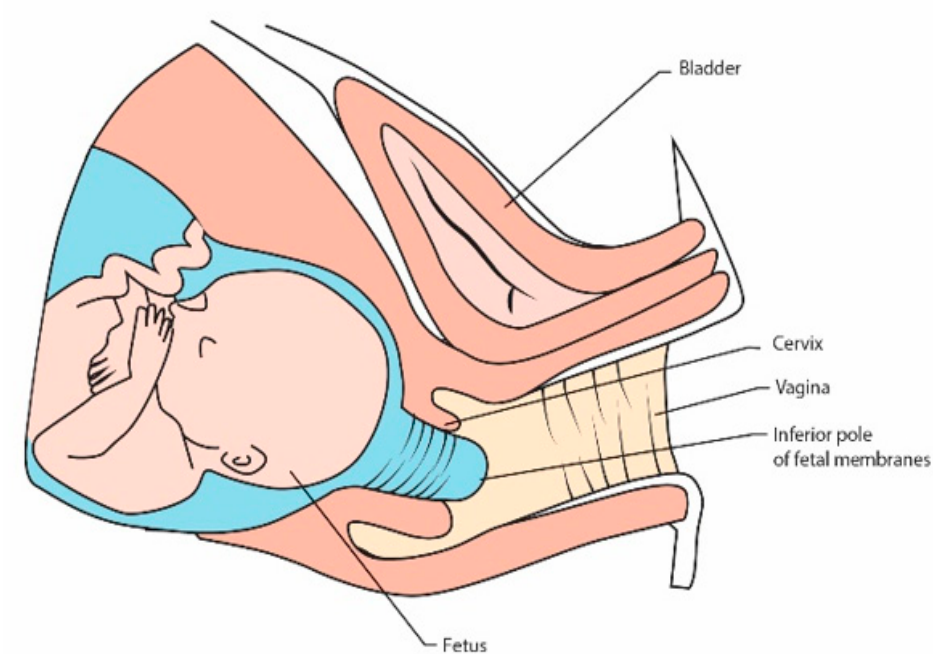
Figure 1. Cervical insufficiency with protruding membranes into vagina.